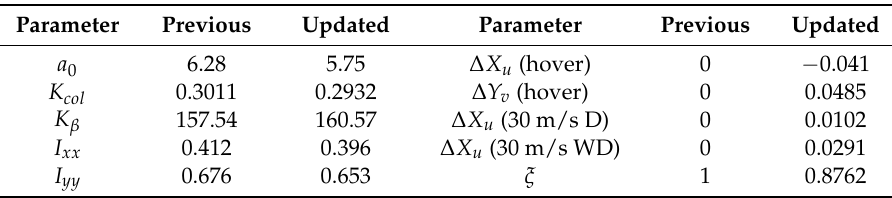
Table 5. Key modified